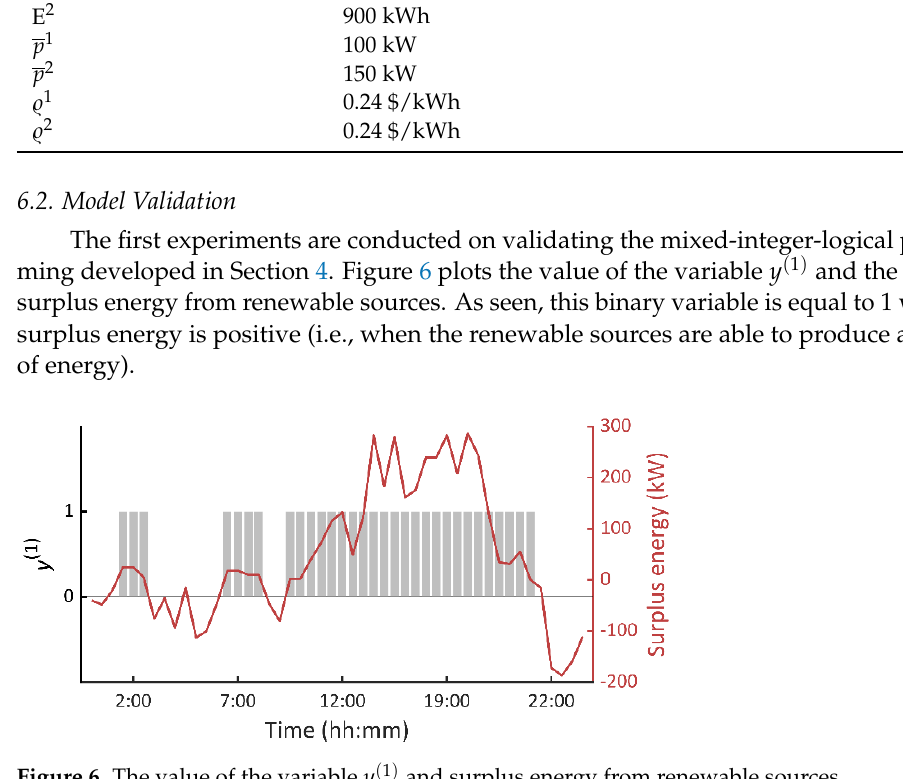
Figure 6. The value of the variable 𝑦 (1) and surplus energy from renewable sources.